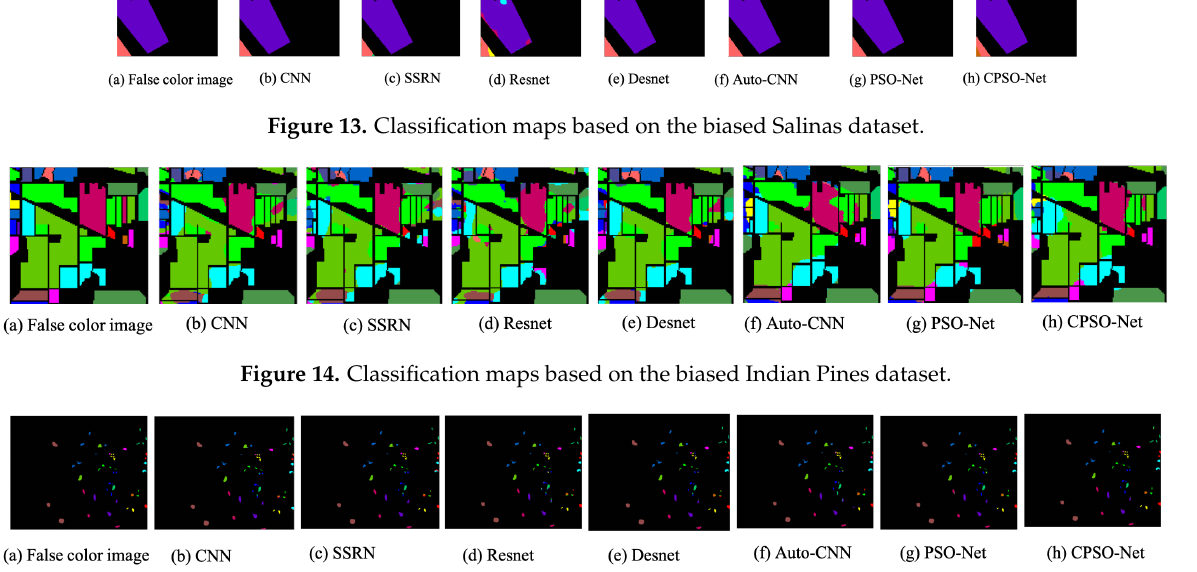
Figure 15. Classification maps based on the biased KSC